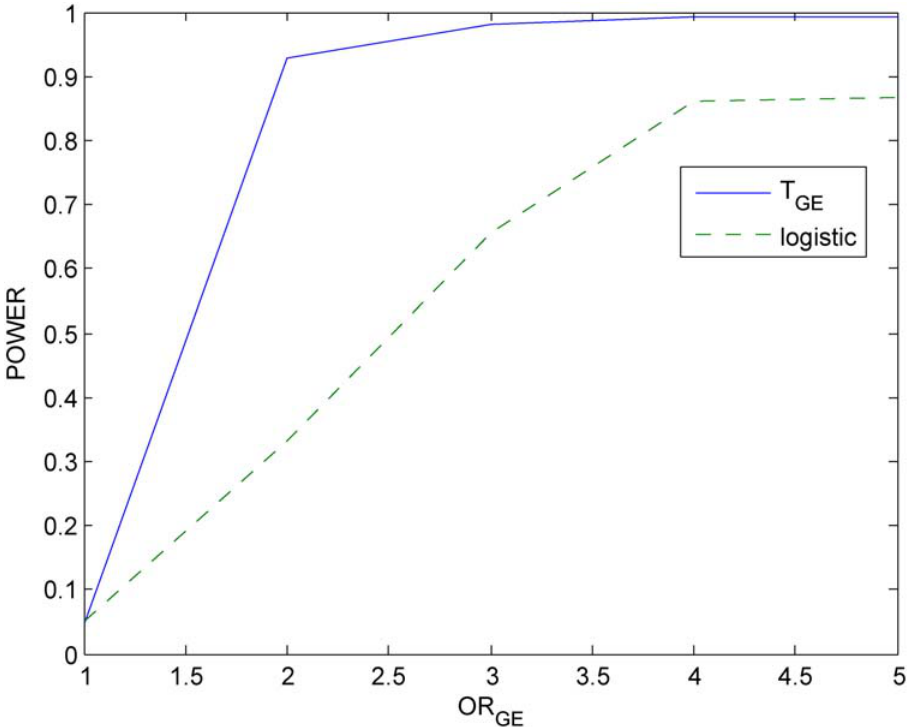
Figure 9. Power of the statistic T I and logistic regression analysis for sample size 400, OR G ~ 2 and OR E ~ 2 .